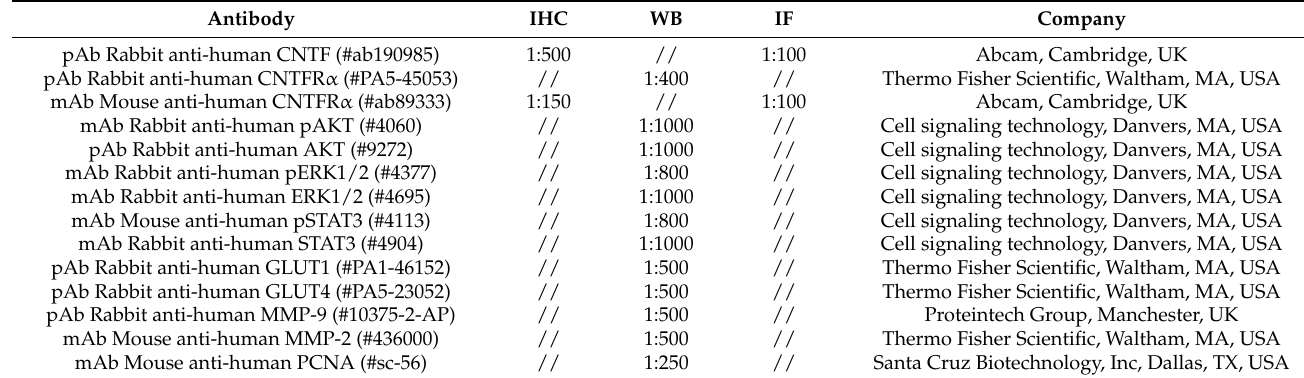
Table 1. Antibodies used in this